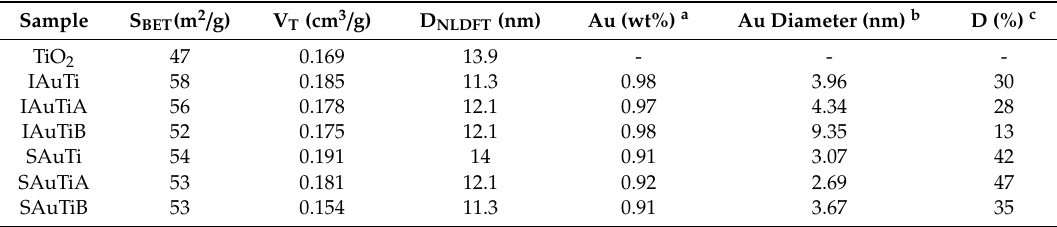
Table 1. Textural properties and concentration, particle size and metal